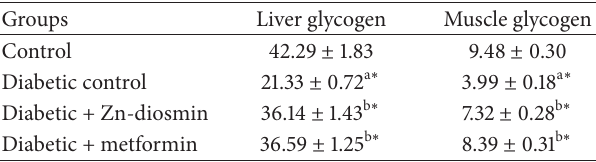
Table 2: Effect of Zn-diosmin complex on glycogen content in liver and muscle tissues of control and experimental groups of